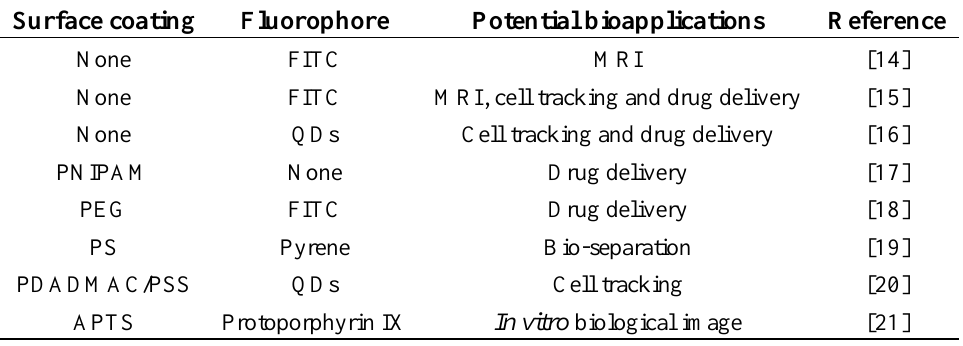
Table 1. Surface modification strategies of silica coated magnetite with fluorescent